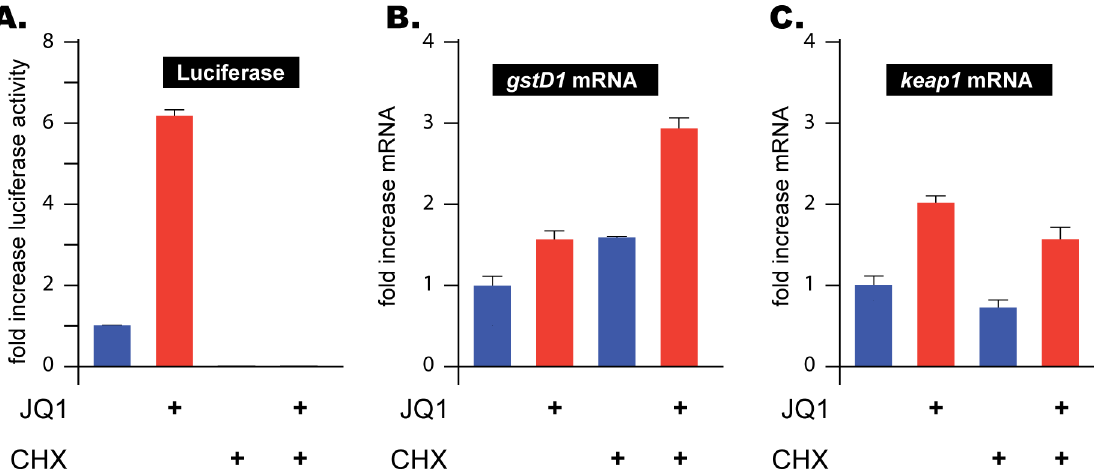
Fig 4. Stimulation of CncC target gene expression is independent of de novo protein synthesis. (A) S2 cells, transfected with the ARE fluc reporter were pre-treated with cycloheximide (CHX) or mock-treated for 4 hours and then exposed to 1 μ M JQ1 or DMSO as a solvent control for 8 hrs. as indicated in the figure. In the absence of CHX luciferase activity was easily detectable and was strongly responsive to JQ1 treatment. No luciferase activity was detectable in CHX-treated cells, both in basal and JQ1-treated conditions. The absence of luciferase indicates that inhibition of de novo protein synthesis in this experiment is efficient. The averages of ARE-luciferase activity in biological replicates are shown here. (B and C) The expression of two CncC- regulated mRNAs ( gstD1 and keap1 ) remained JQ1 inducible in in the absence (P < 0.05 and P < 0.01 respectively for gstD1 and keap1 ) and the presence of CHX (P < 0.01 and P < 0.02 respectively for gstD1 and keap1 ). Note that gstD1 expression, like that of many other stress-inducible genes [35, 36] increases in the presence of CHX. Nevertheless, the JQ1 response remains robust under CHX treatment also in this case. The mRNA levels were normalized to actin5C transcript levels. The error bars indicate standard deviation of 3 biological